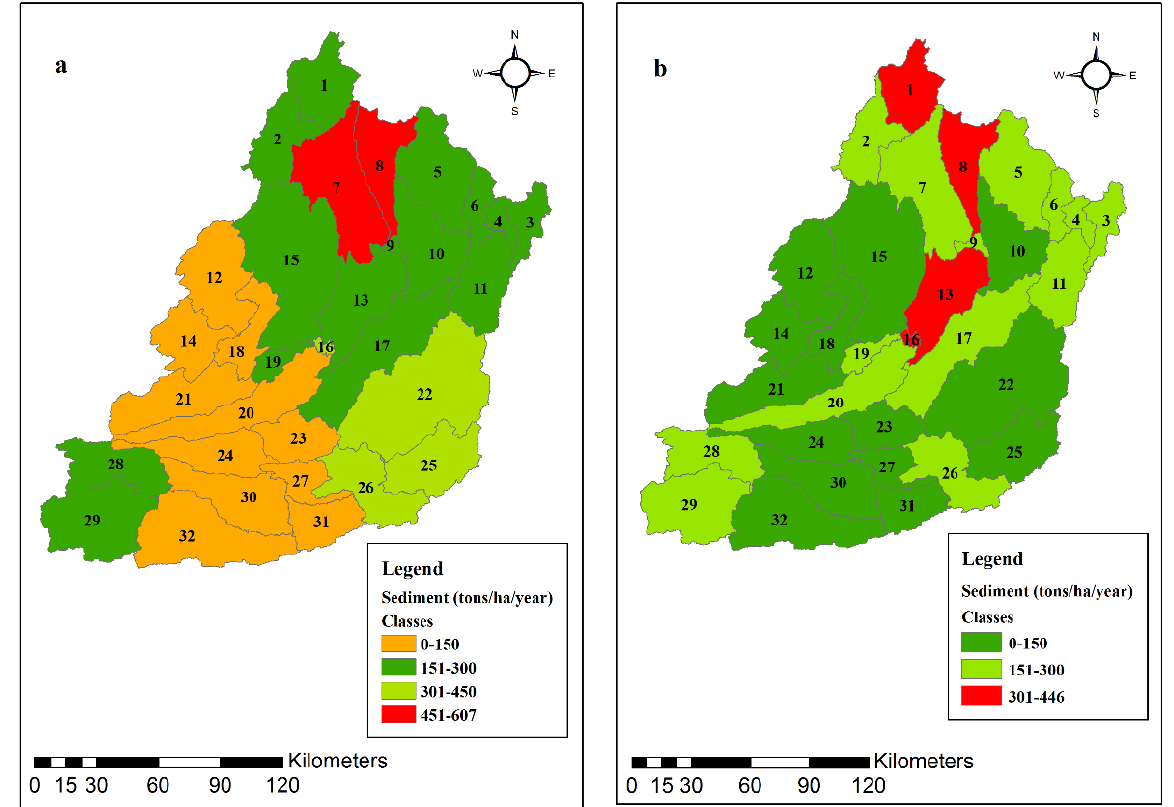
Figure 9. Spatial distribution of sediment yield in the Gomal River catchment: ( a ) tank rainfall station dataset; ( b ) GPCC gridded dataset.